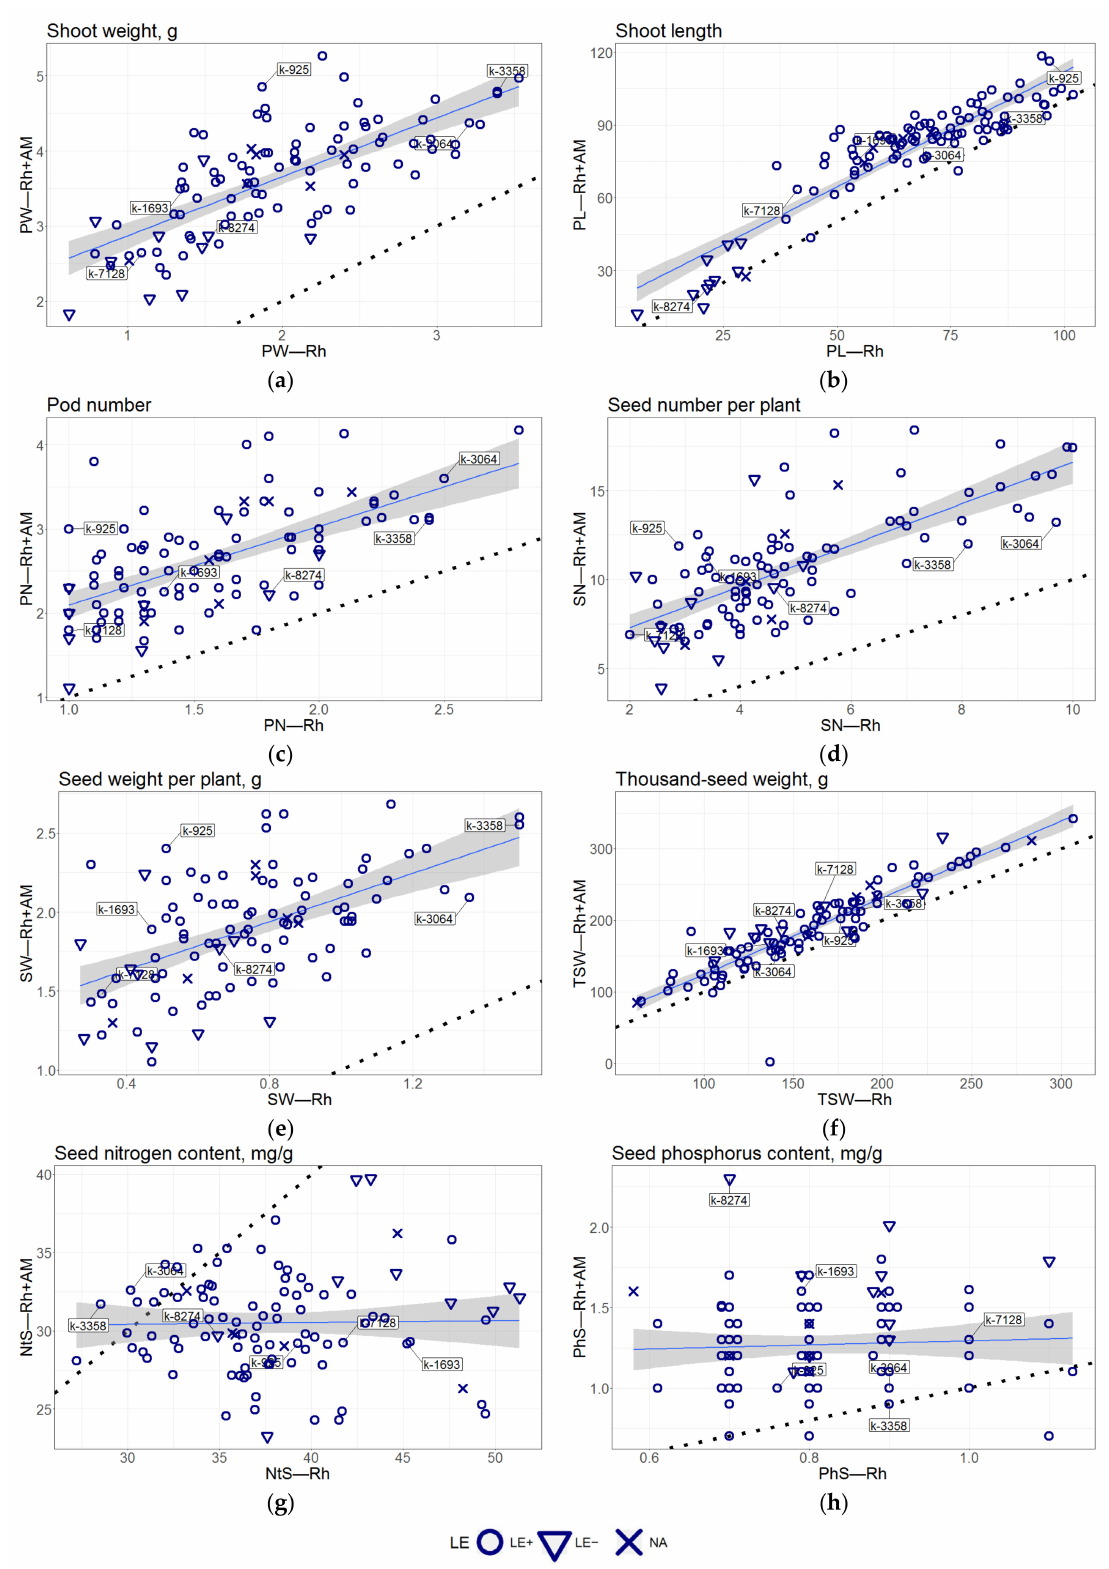
Figure 1. Scatterplots of traits as measured for analyzed pea cultivars grown under single inoculation with rhizobia ( x -axis, Rh) and double inoculation with rhizobia and AM fungi ( y -axis, Rh + AM). The blue line is the linear regression graph; the dotted line is the y = x graph, representing the hypothetical absence of difference between inoculations. The following traits are presented: ( a ) PW—shoot weight, g; ( b ) PL—shoot length, cm; ( c ) PN—pod number; ( d ) SN—seed number per plant; ( e ) SW—seed weight per plant, g; ( f ) TSW—thousand-seed weight, g; ( g ) NtS—seed nitrogen content, mg/g; ( h ) PhS—seed phosphorus content,